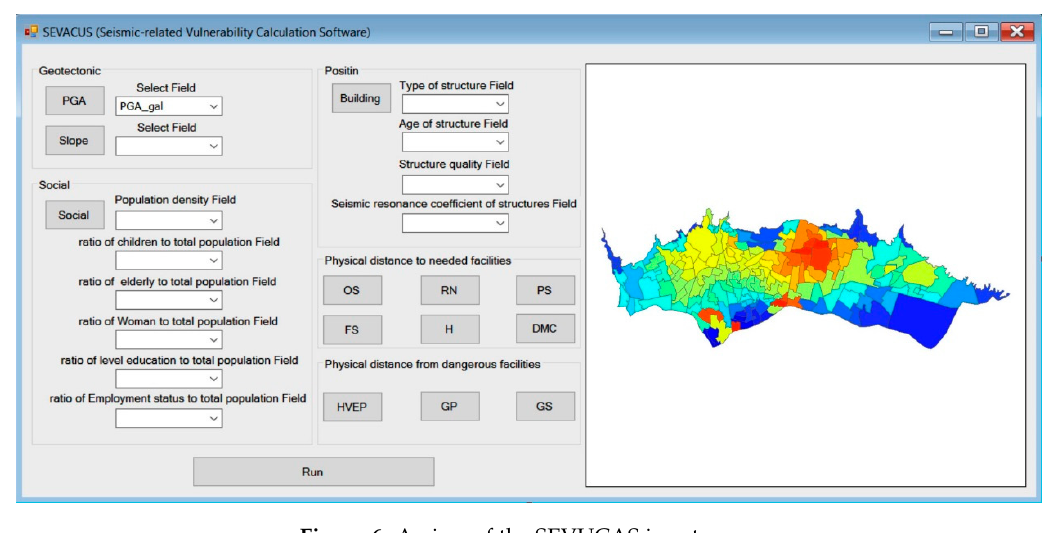
Figure 6. A view of the SEVUCAS input page.